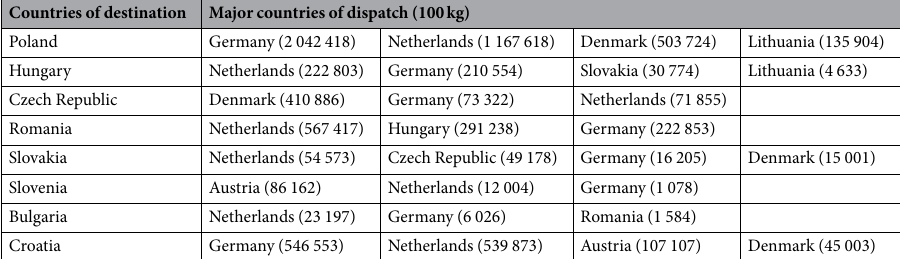
Table 1. Major countries of dispatch regarding live piglet trade (below 50 kg of bodyweight) into CE destinations, according to available EUROSTAT data